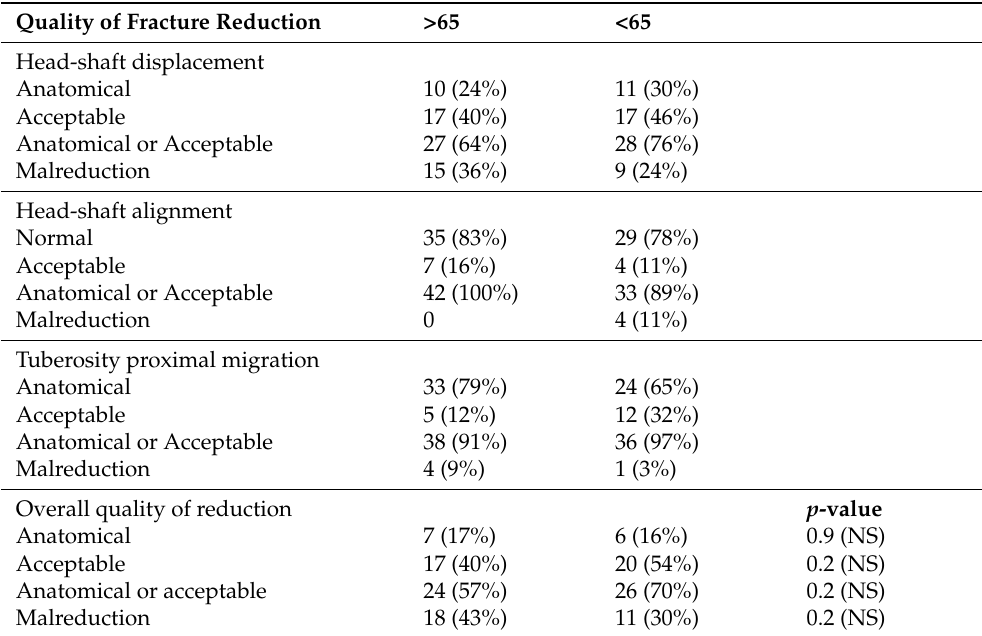
Table 3. Quality of fracture reduction according to Schnetzke et al. Regarding the quality of fracture reduction, both groups are comparable without significant differences.